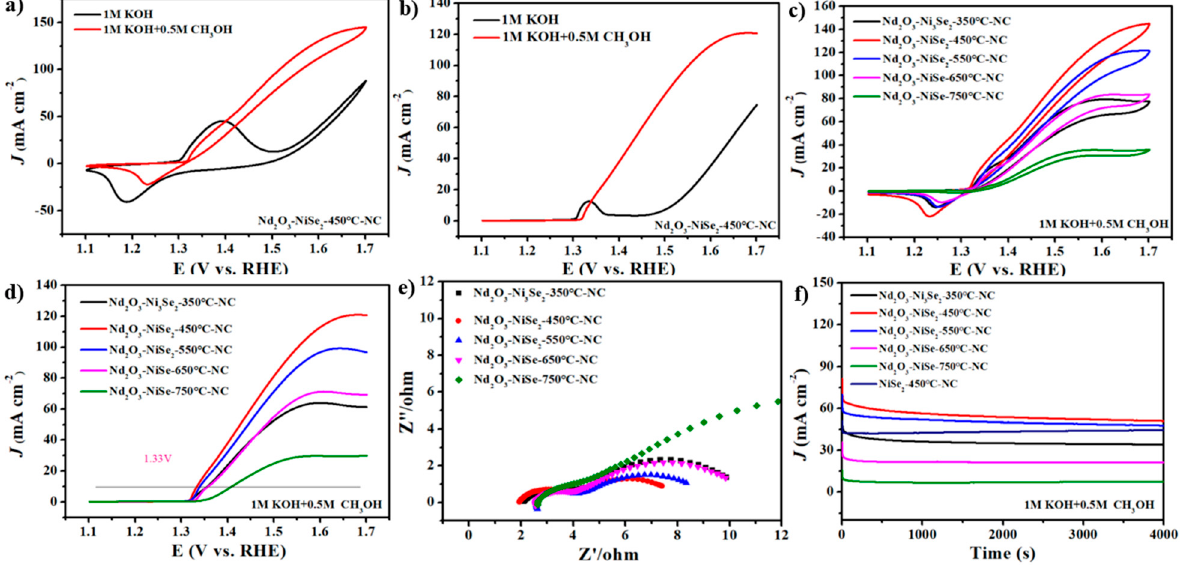
Figure 4. ( a ) CVs of Nd 2 O 3 -NiSe 2 -450 ◦ C-NC in 1 M KOH and 1 M KOH+ 0.5 M MeOH (sweep speed: 50 mV s − 1 ); ( b ) LSV of Nd 2 O 3 -NiSe 2 -450 ◦ C-NC in 1M KOH and 1 M KOH+ 0.5 M